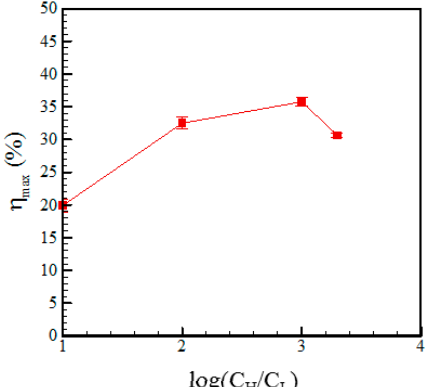
Figure 8. Variation of the energy conversion efficiency with the concentration ratio given a microchannel length of 1 mm.